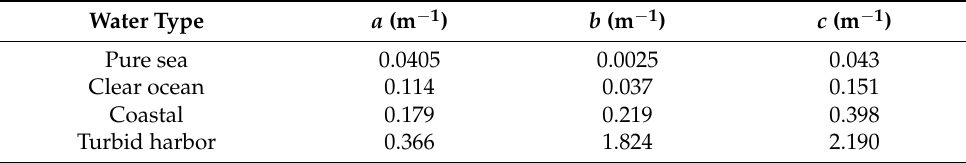
Table 2. Typical attenuation coefficients for different water